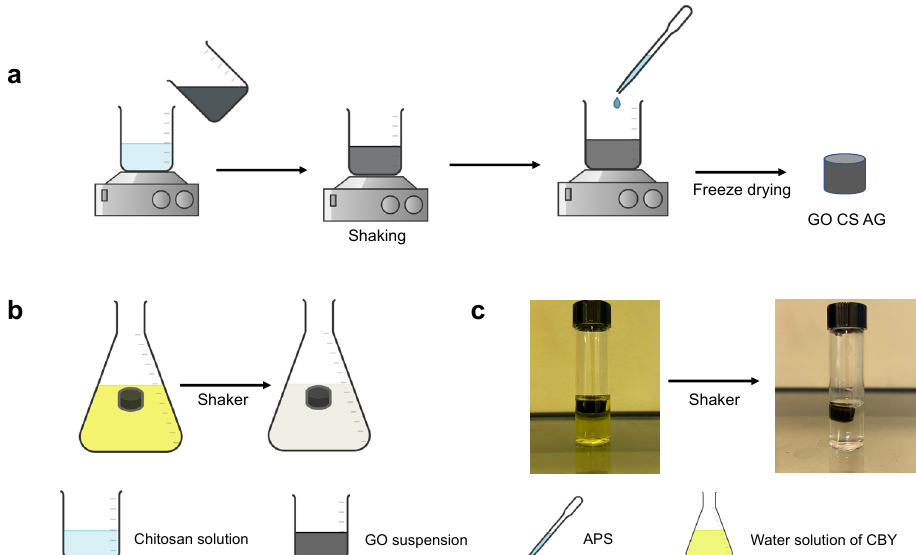
Figure 1. ( a ) Schematization of the synthesis method for GO-CS aerogels: GO suspension is added, under vigorous stirring, to chitosan aqueous solution. The addition of APS as oxidant agent promotes the crosslinking of the polymeric framework and the final gel is recovered through freeze drying. ( b ) Schematization of the removal of organic dye from water solution working with the synthetized aerogels. ( c ) Real application of the GO-CS AG in the removal of CBY from aqueous solution (C 0 = 100 mg/L, shaking for 20 min).